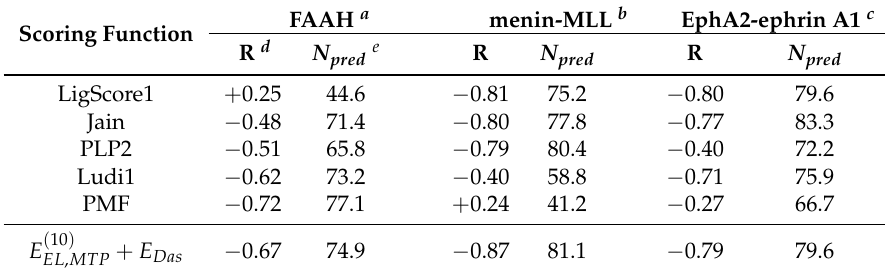
Table 5. Performance of empirical scoring for FAAH, menin-MLL and EphA2-ephrin A1 systems. ( 10 ) + E The results obtained for nonempirical E Das model are provided for comparison. EL , MTP FAAH a menin-MLL b EphA2-ephrin A1 c Scoring Function R d N pred e R N pred R N pred LigScore1 + 0.25 44.6 − 0.81 75.2 − 0.80 79.6 Jain − 0.48 71.4 − 0.80 77.8 − 0.77 83.3 PLP2 − 0.51 65.8 − 0.79 80.4 − 0.40 72.2 Ludi1 − 0.62 73.2 − 0.40 58.8 − 0.71 75.9 PMF − 0.72 77.1 + 0.24 41.2 − 0.27 66.7 ( 10 ) + E − 0.67 74.9 − 0.87 81.1 − 0.79 E Das EL , MTP